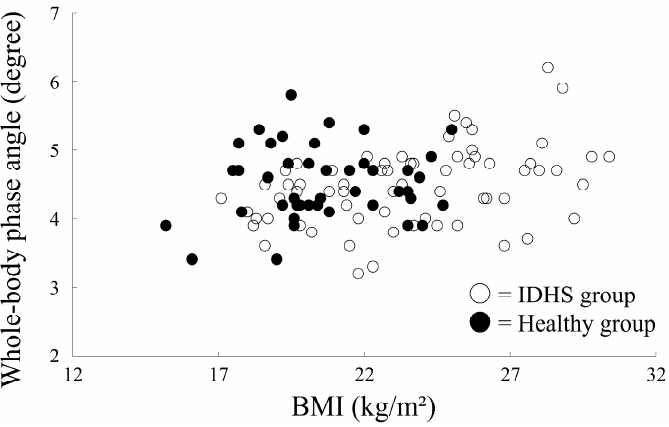
Figure 2. Correlation between FFMI and phase angle in both groups.